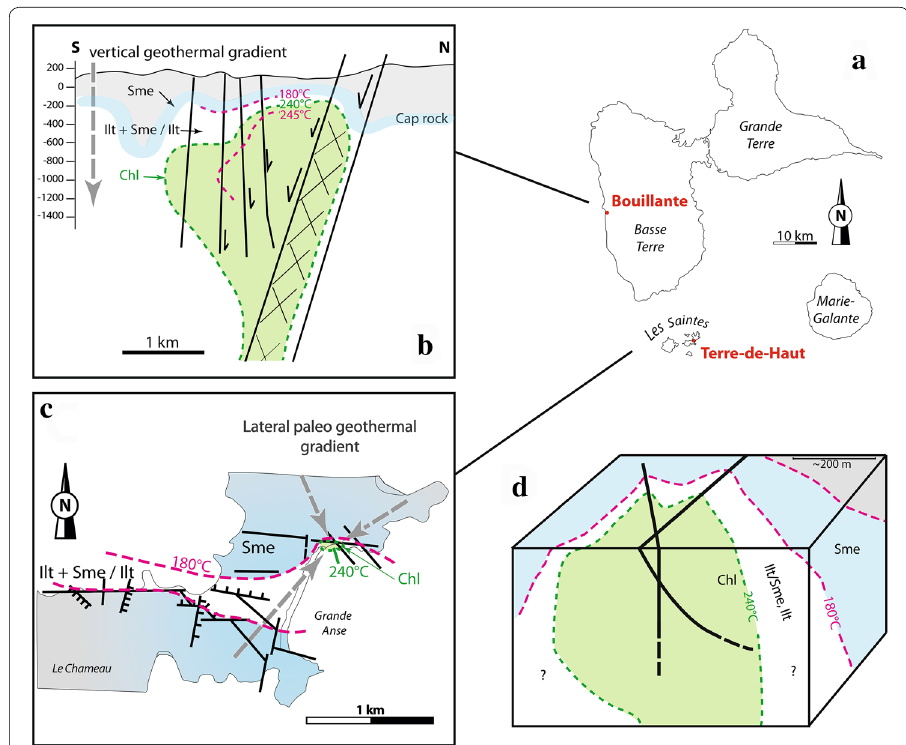
Fig. 10 Comparison and interpretation of clay mineral repartitions of active- and paleo-geothermal systems of Bouillante and Terre-de-Haut, respectively. a Map of the Guadeloupe archipelago with locations of the active Bouillante geothermal system, and of the paleo-geothermal system of Terre-de-Haut. b Schematic 2-D view of the repartition of the clay minerals in Bouillante geothermal system [modified after Bouchot et al. (2010)]; c 2-D representation of the clay mineral distribution in the exhumed paleo-geothermal system of Terre-de-Haut associated to the paleo-isotherms deduced from Bouillante active geothermal system (Bouchot et al. 2010). d 3-D interpretation of the geothermal systems in Guadeloupe, with their clay mineral distribution. Black lines correspond to hypothetic